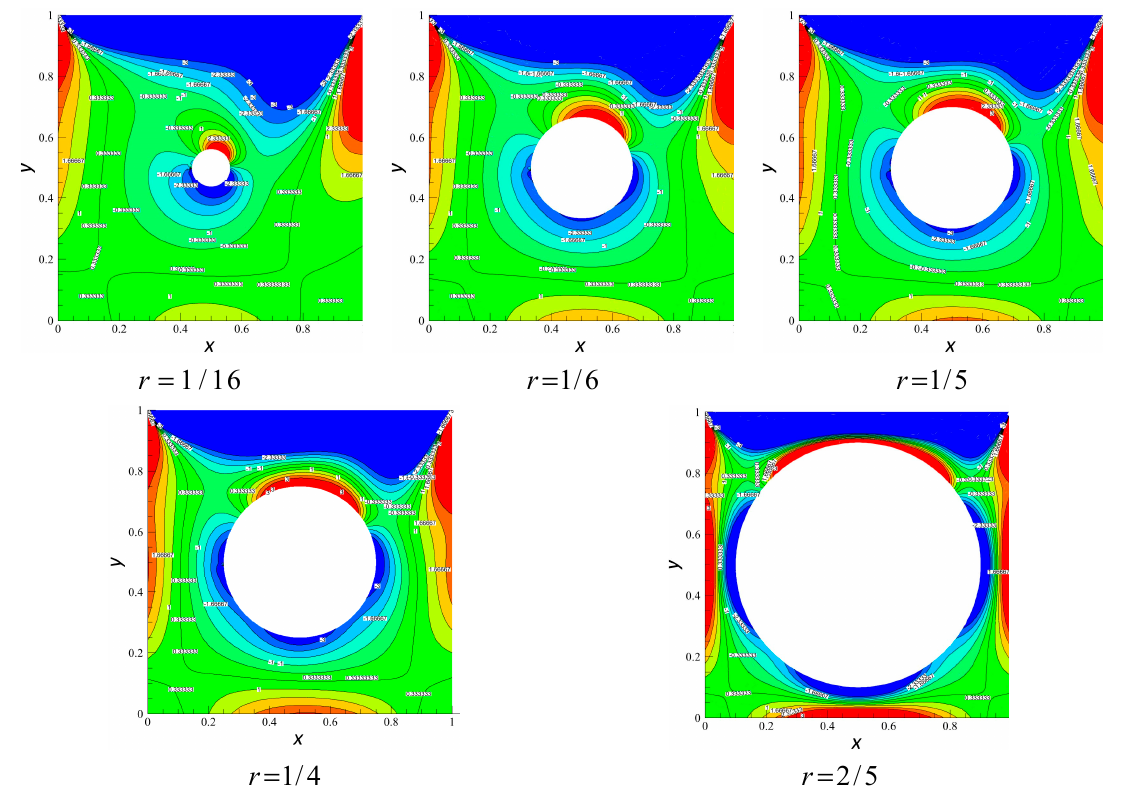
Figure 9. Vorticity contours for various r at Re = 100.